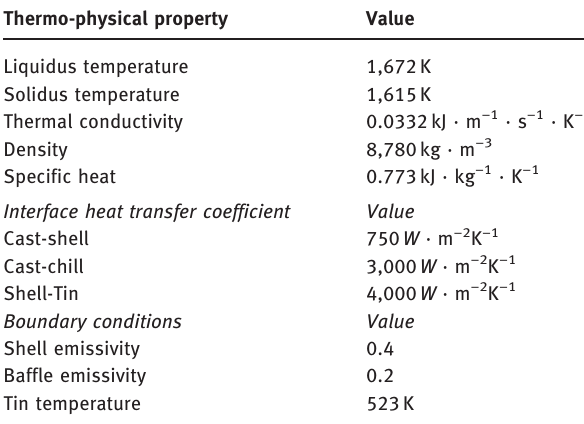
Table 1: Key parameters and values for simulation [5,